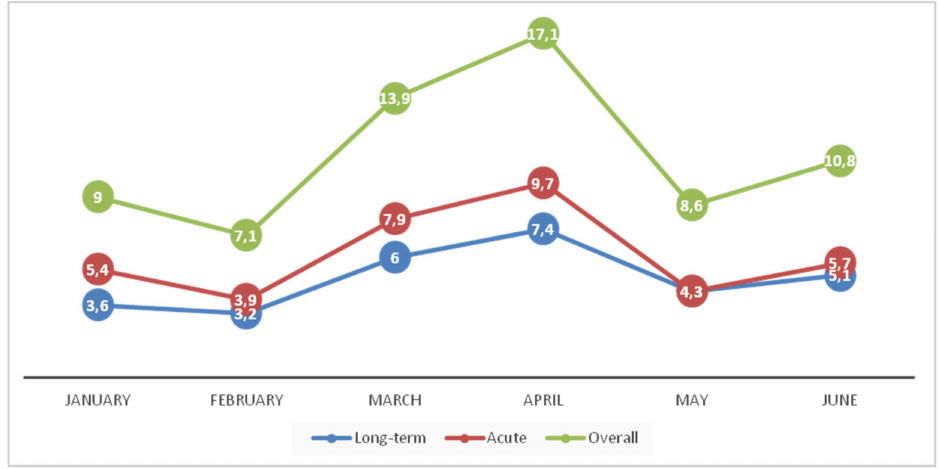
Figure 1. Clostridioides ( Clostridium ) di ffi cile infection incidence during the study